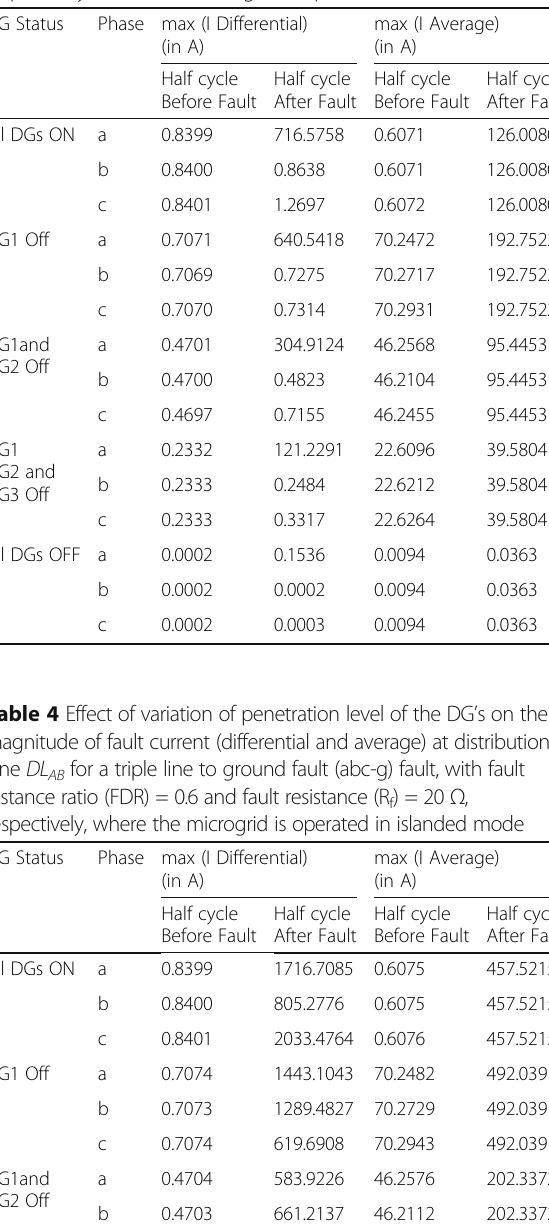
Table 3 Effect of variation of penetration level of the DG ’ s on the magnitude of fault current (differential and average) at distribution Line DL AB for a single line to ground fault (a-g) fault on at fault distance ratio ( FDR ) = 0.4 and fault resistance (R f ) = 5 Ω , respectively, where the microgrid is operated in islanded